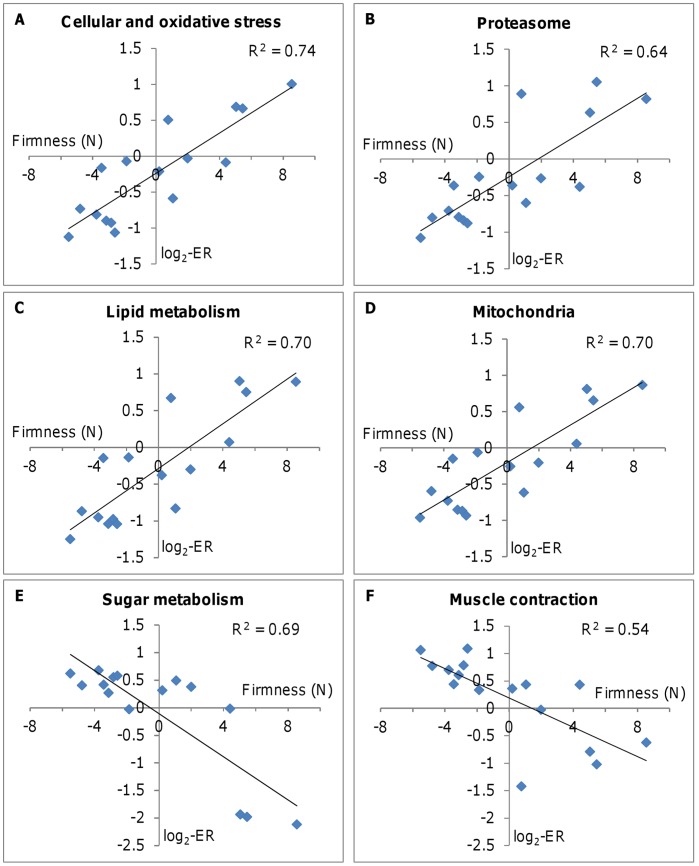
Relationship between fillet firmness and expression of genes from different functional groups in salmon skeletal muscle (n = 16 fish).Data are mean centered values of firmness (X-axis) and mean log2-ER (Y-axis), and R2 is the coefficient of determination. A: responses to protein and oxidative stress (11 genes); B: proteosomal degradation of proteins (41 genes); C: lipid and steroid metabolism (30 genes); D: mitochondrial proteins (129 genes); E: metabolism of sugars (26 genes); F: muscle contraction (42 genes).